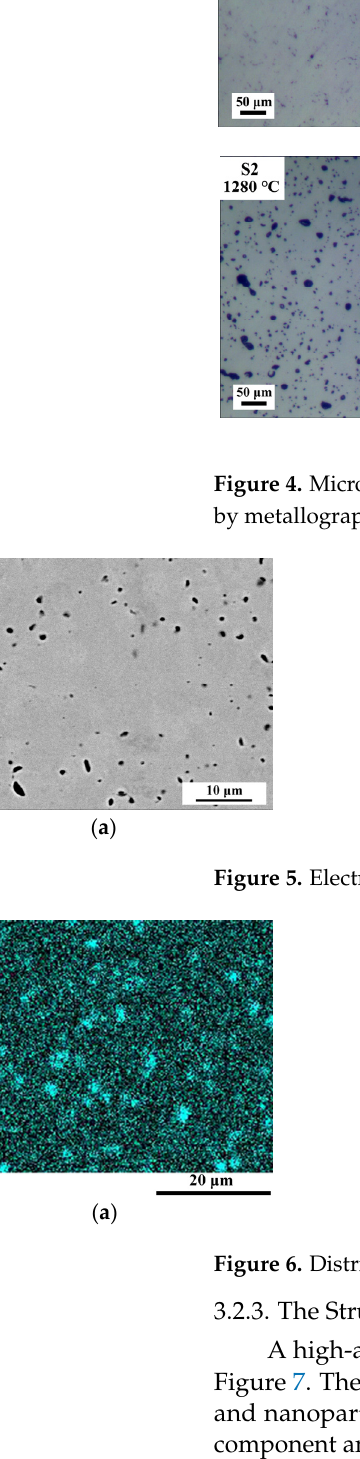
( b ) Figure 7. ( a ) High-angle circular dark field (HAADF) image of 1280-S3 ODS steels. ( b ) Line scan component analysis of 1280-S3 ODS steels. EDS analysis on the red mark in Figure 7 is shown in Figure 8; the core of the micro- particle was mainly composed of Si and O with the atomic ratios of 25.69% and 16.92%, respectively. The formation of these SiO X and some Si-O-Y clusters was a result of the high oxygen affinity of Si and Y. The solutes Si and Y combined with O atoms during the sin- tering process to precipitate the microparticle, which confirmed the strong binding ener- gies between Si, Y and O solutes in the above calculation results.